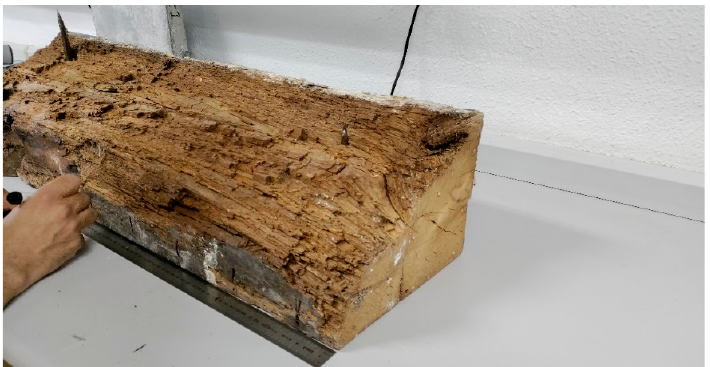
Figure 15. Rot sample: decay condition in the extracted timber section. Almost 50% of the wood section is damaged.